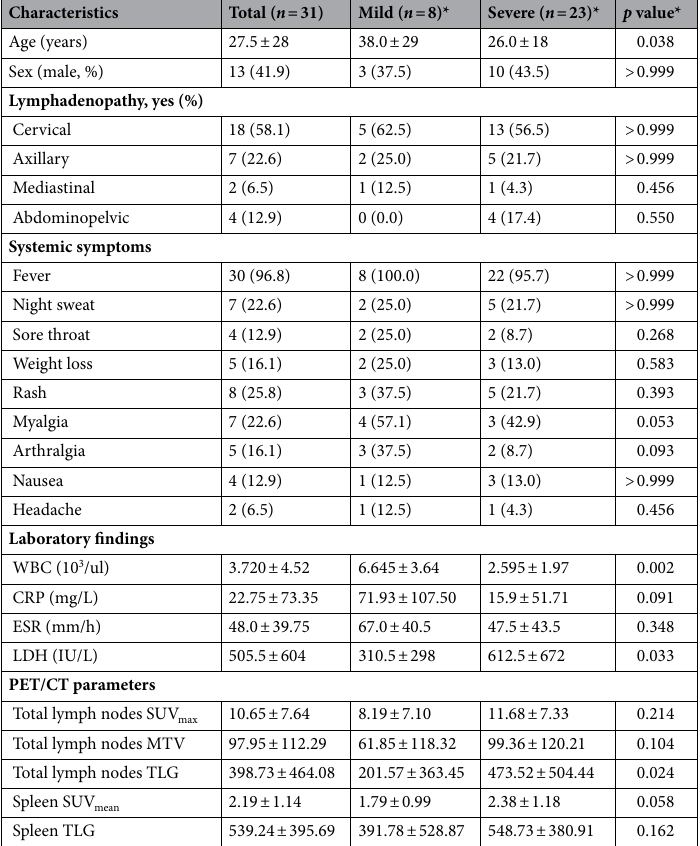
Table 1. Patient characteristics and results of univariate analysis for predicting the severity of Kikuchi- Fujimoto disease. WBC, white blood cell count; CRP, C-reactive protein; ESR, erythrocyte sedimentation rate; LDH, lactate dehydrogenase; PET/CT, positron emission tomography/computed tomography; SUV max , maximum standardized uptake value; MTV, metabolic tumor volume; TLG, total lesion glycolysis; SUV mean , mean standardized uptake value Continuous variables are presented as means ± standard deviation and medians ± interquartile range (3rd interquartile range-1st interquartile range), and categorical variables are presented as numbers (percentage) * Statistical analysis performed mild and severe